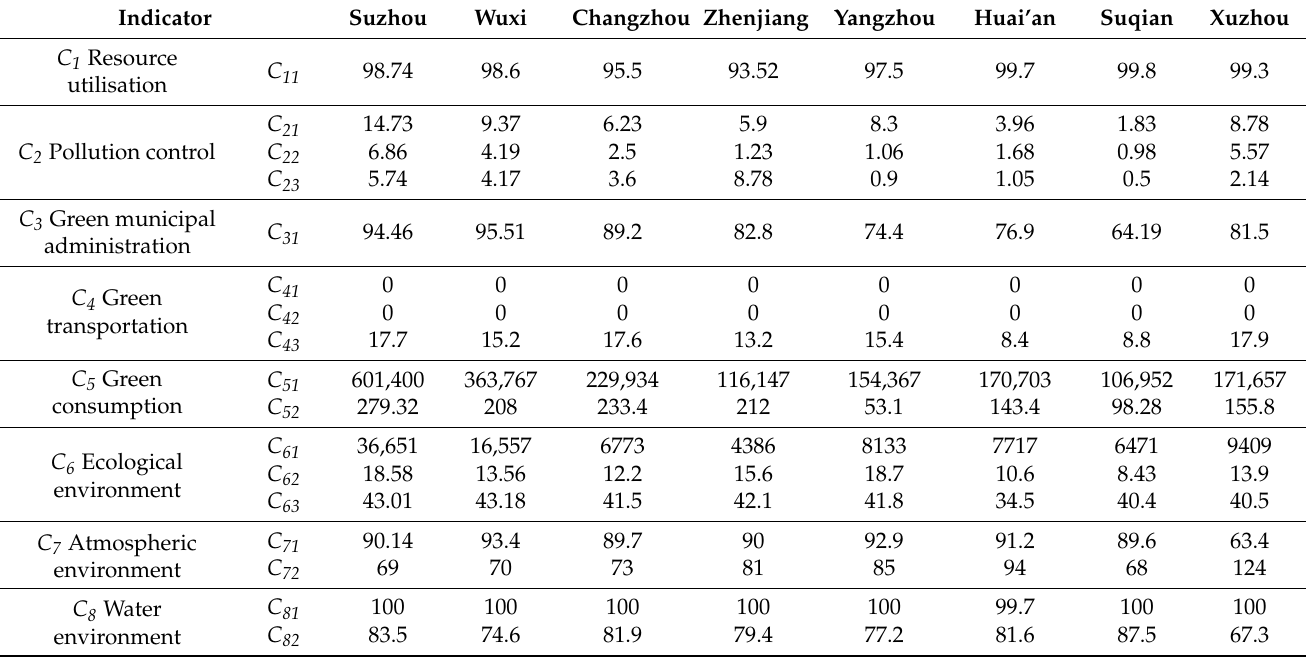
Table A3. Quantitative data on evaluation indicators for